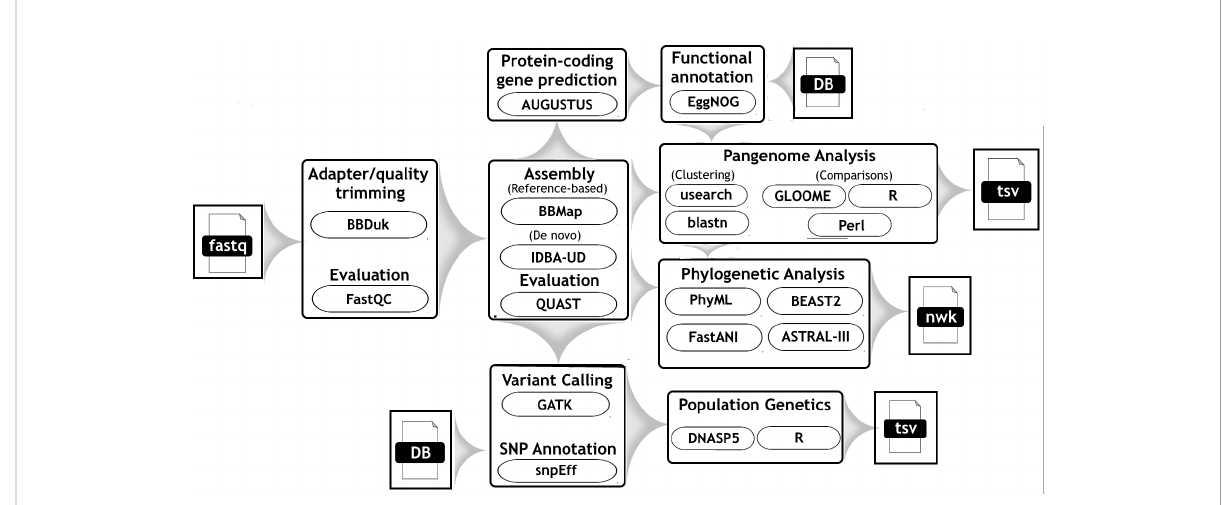
FIGURE 1 Work fl ow diagram which describes the bioinformatic steps taken to differentiate genomes of G. duodenalis assemblage A